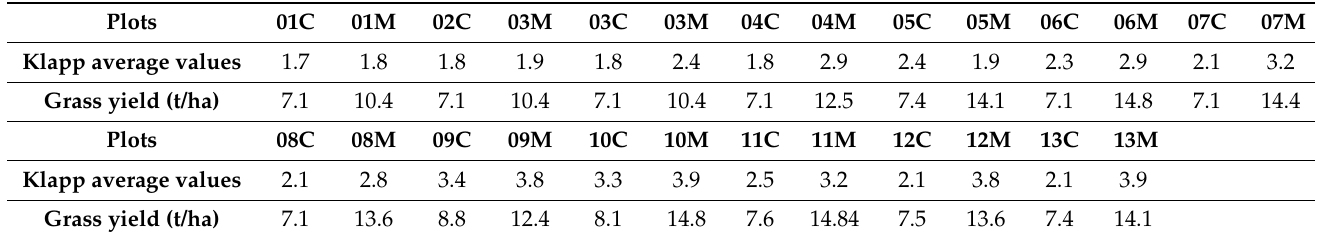
Table 2. Control and mown zones based on the average value of Klapp’s forage values (01, 02 etc.: years, C: control, M: